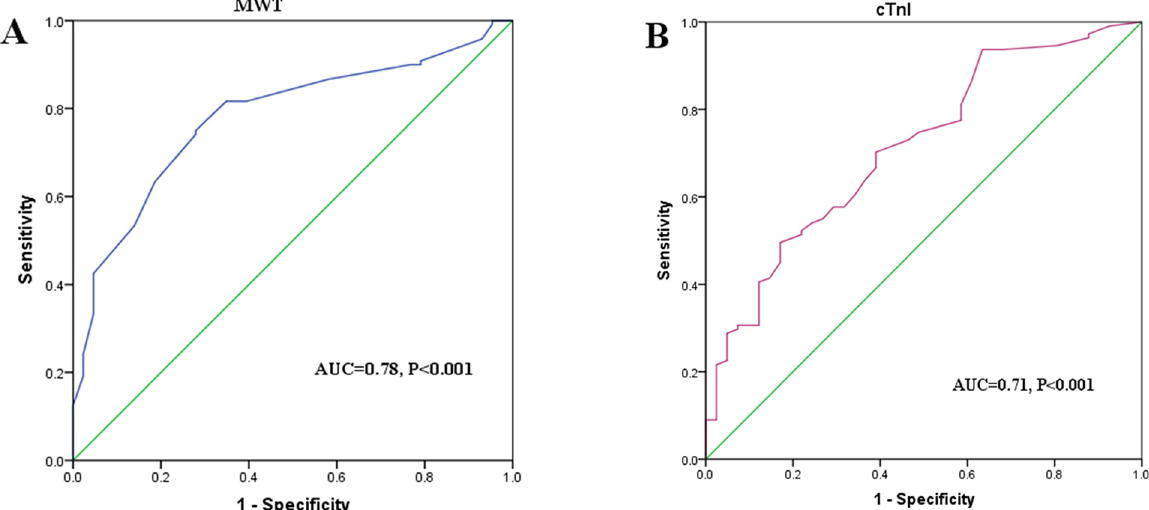
Fig 5. Receiver operating characteristic (ROC) curves of MWT (A) and cTnI (B) to predict the presence of LGE. AUC indicates area under ROC curve. Other abbreviations as in Figs 1 and 2.